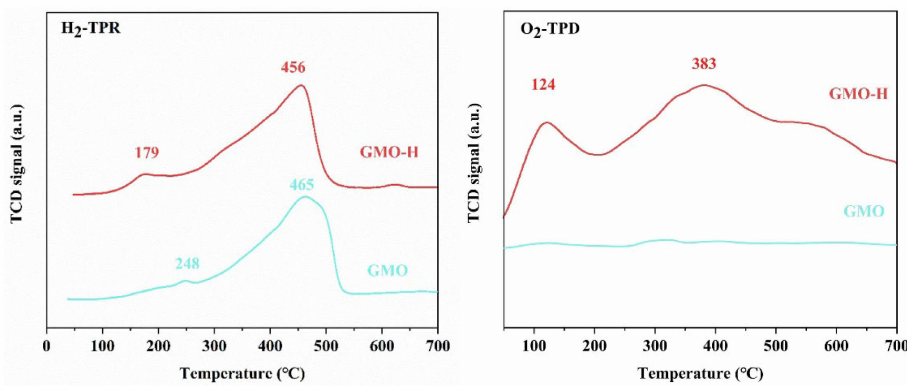
Figure 5. H 2 -TPR and O 2 -TPD of GMO,